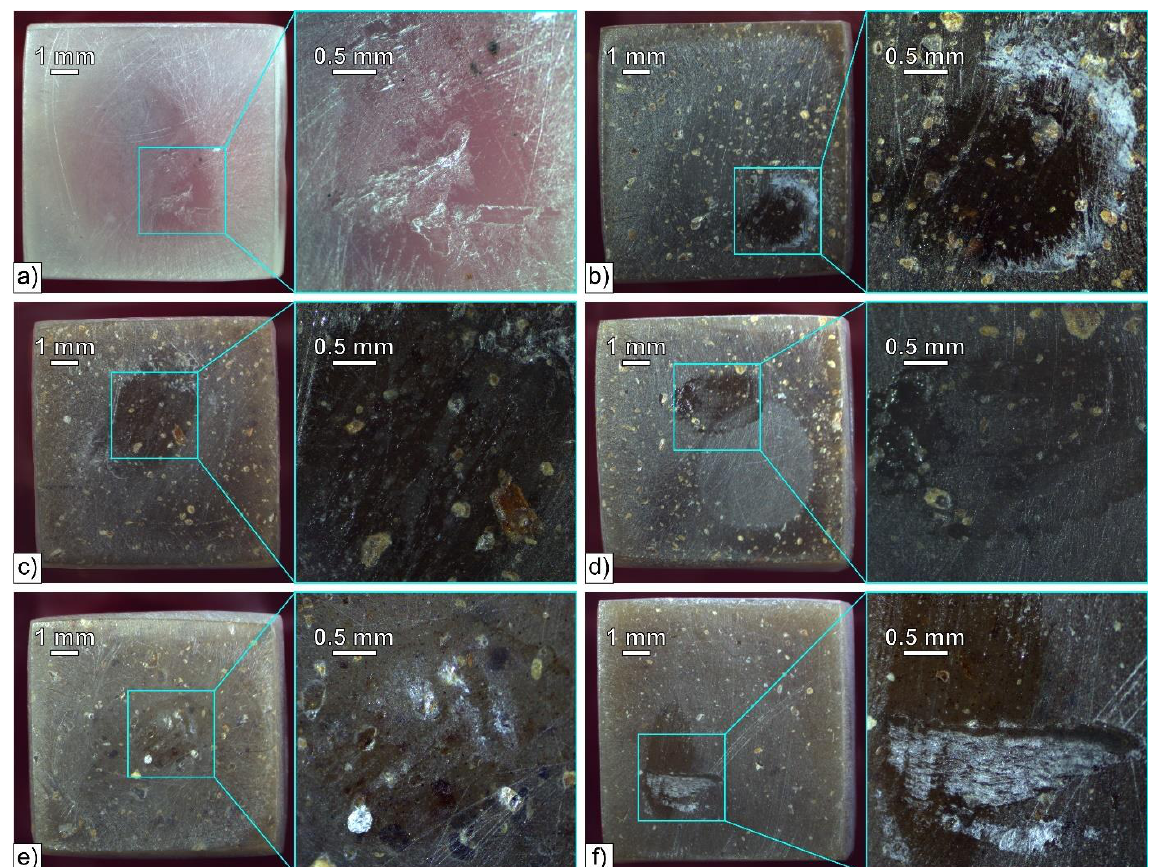
Figure 6. Microscopic images of the worn surfaces of PLA ( a ), PLA-LC0.9 ( b ), PLA-LC4.6 ( c ), PLA-LC17.7 ( d ), PLA-LC30.4 ( e ), and PLA-LC39.8 ( f ).